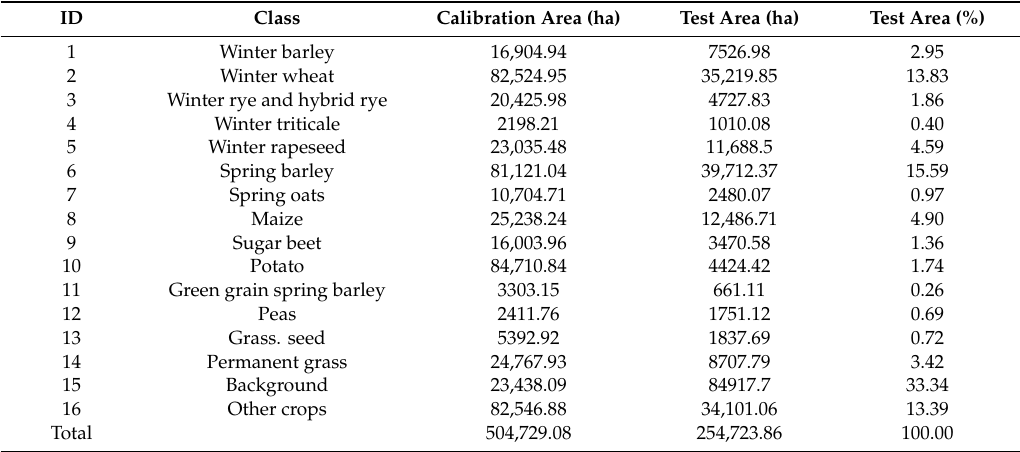
Figure 1. Training and test regions in Denmark (the red and blue color zones represent training and test regions). Table 1. The distribution of agricultural crop types in